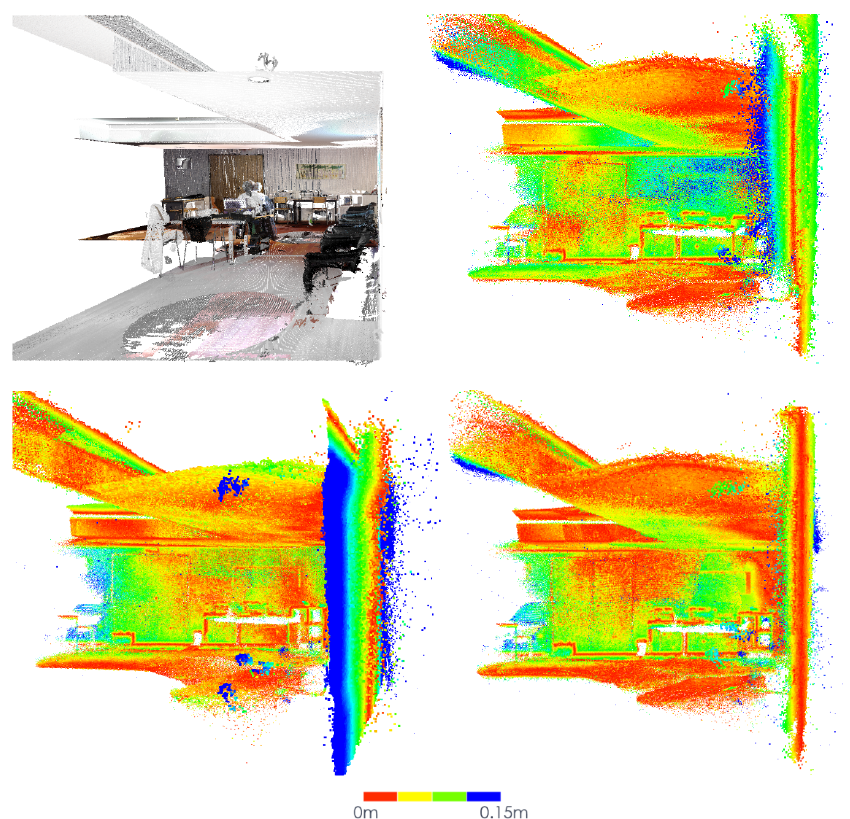
Figure 23. MeetingRoom dataset colourmapped with Hausdorff distance to FARO laser scanned point cloud (detail): ( top-left ) Groud truth laser scan; ( top-right ) Google Tango; ( bottom-left ) ICP; ( bottom-right ) Our approach.